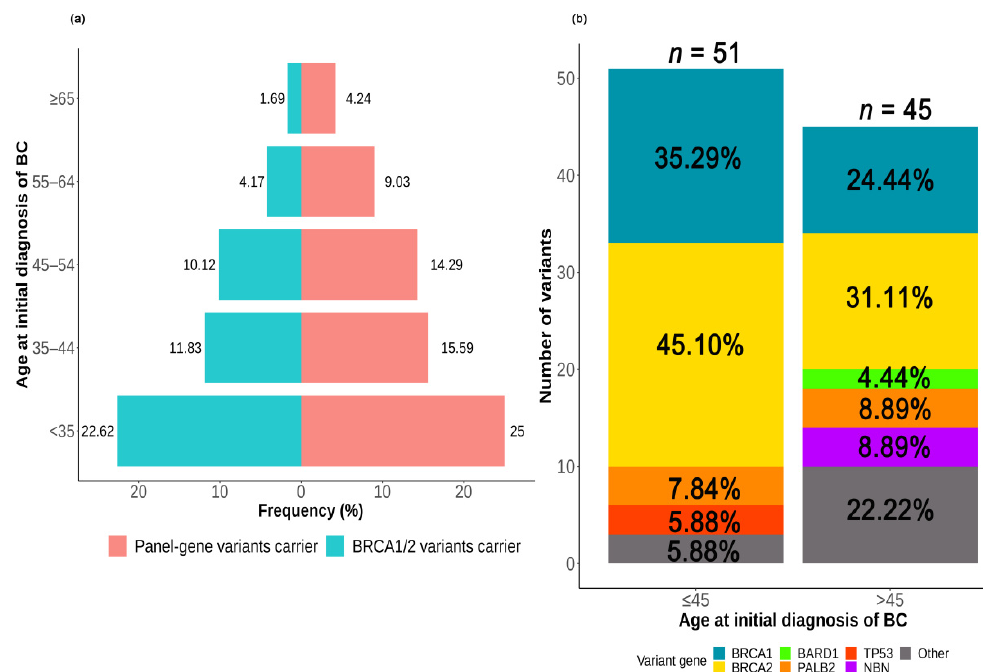
Figure 3. Association between deleterious germline variants and age at the initial diagnosis of breast cancer. ( a ) The variant rates according to age at initial diagnosis of breast cancer, ( b ) distribution of the variants according to age at initial diagnosis of breast cancer. Abbreviation: BC = breast cancer.